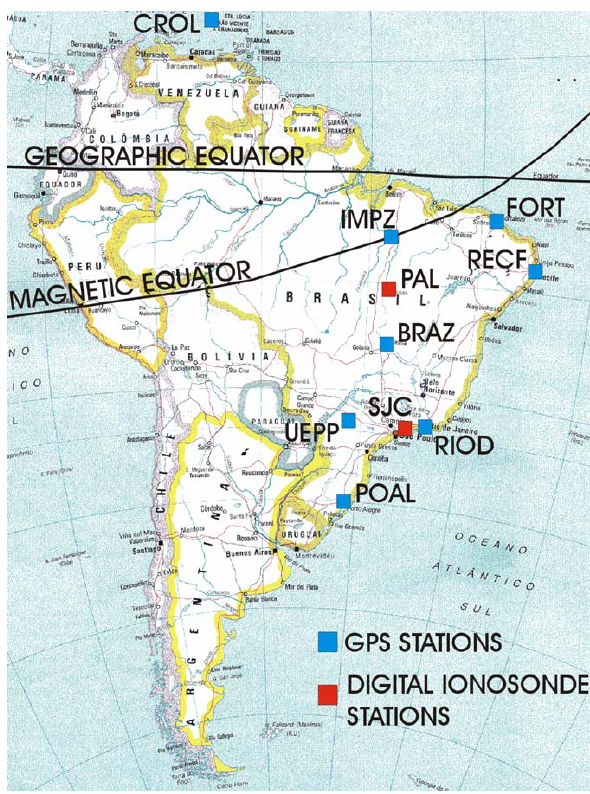
Fig. 1. Map of South America showing the locations of the iono- spheric sounding and GPS receiving stations. Also, the geographic and magnetic equators are shown.